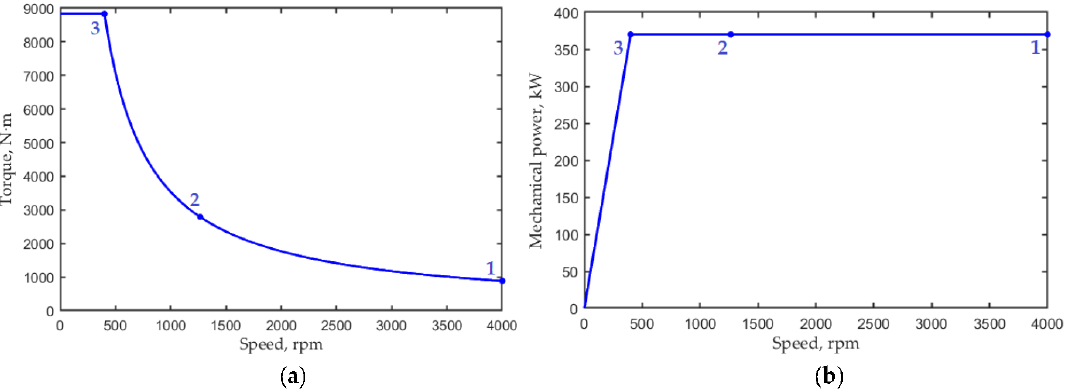
Figure 3. Traction characteristics of the motor: ( a ) torque vs. rotational speed; ( b ) output mechanical power vs. rotational speed.